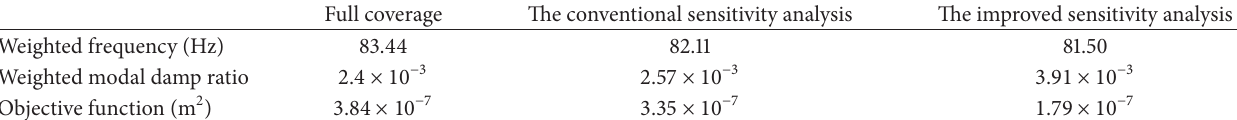
Table 3: A comparison between CLD system with full coverage and the layout of CLD material.